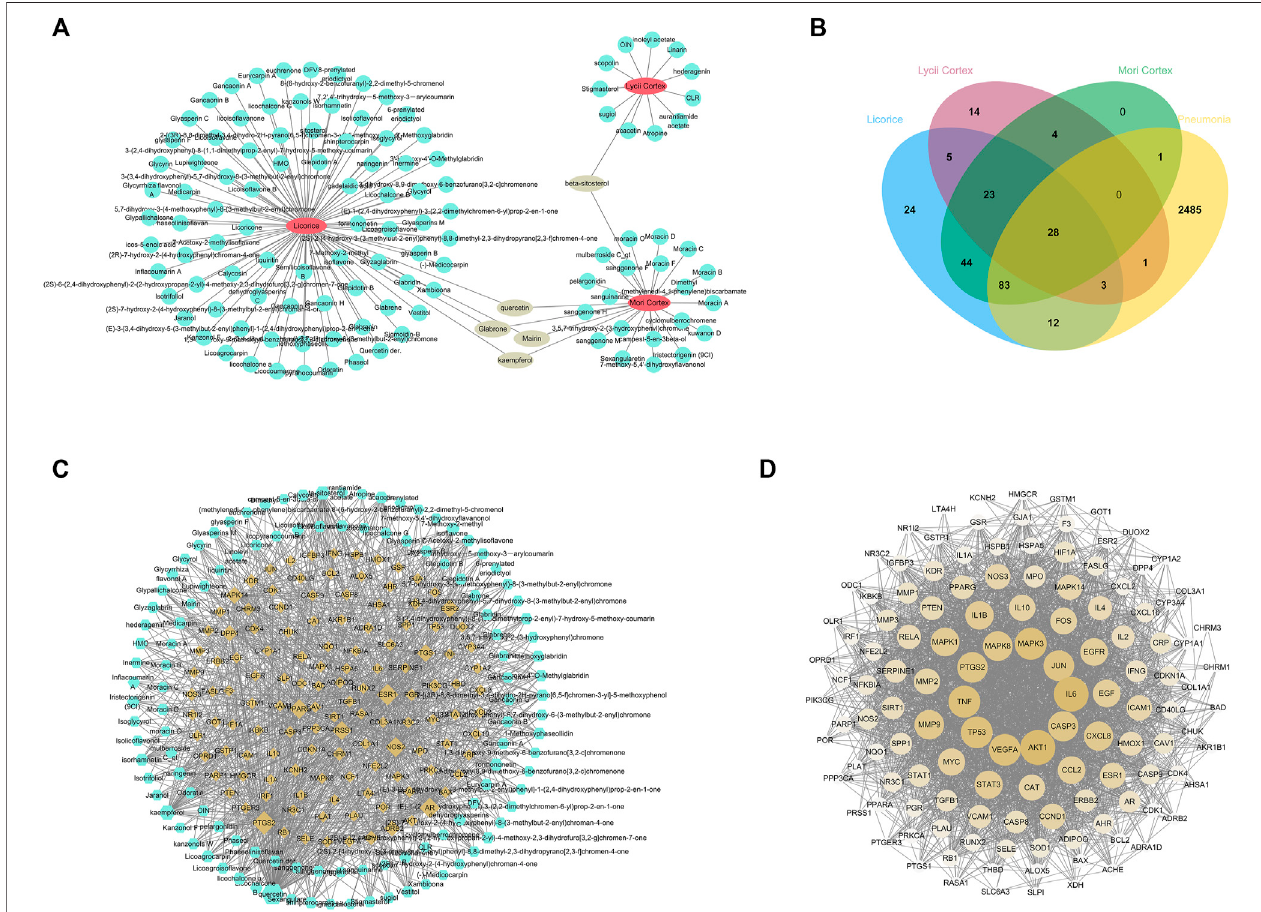
FIGURE 1 | Network pharmacology predicted the active ingredients-target interactions for XBS against pediatric pneumonia. (A) The network of Herbs-active ingredients connection. The red nodes represent ingredients in XBS while the blue ones represent active ingredients. (B) The venn diagram for ingredients and pneumonia targets. The 128 overlap targets common between the predicted XBS targets and the pneumonia-related targets. (C) Network of targets predicted via the XBS-active ingredients. Blue nodes represent the active ingredients in XBS, whereas the yellow nodes represent the predicted targets. The edges represent the interaction between compounds and targets. (D) PPI network of the XBS ingredients targets against pediatric pneumonia.